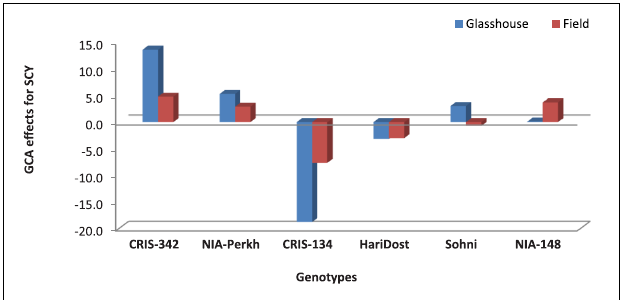
FIGURE 6 | Estimates of GCA effects for SCY (g/plant) in six parents data based on F 1 generation. present study, maximum negative mid-parent and better parent heterosis were observed in HariDost × CRIS-342, Sohni × CRIS- 342, NIA-148 × CRIS-342, and NIA-148 × NIA-Perkh, while the maximum positive heterotic effects were produced by hybrids NIA-148 × CRIS-134 and HariDost × NIA-Perkh under both temperature regimes. The results of heterosis for SCY (g/plant) have shown maximum significant positive heterosis and heterobeltiosis under both heat stress and non-heat stress regimes in the crosses HariDost × CRIS-342, Sohni × CRIS- 342, Sohni × NIA-Perkh, NIA-148 × CRIS-342, and NIA- 148 × NIA-Perkh. However, maximum negative heterotic effects were observed in cross NIA-148 × CRIS-134 in heat